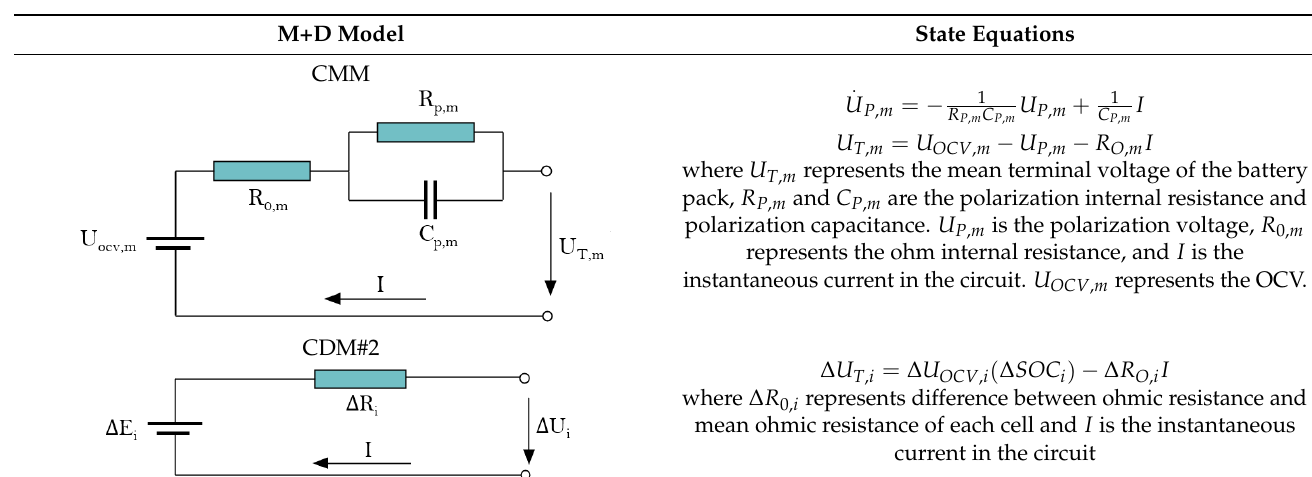
Table 1. State equations of M+D model. Adapted from ref. [28].